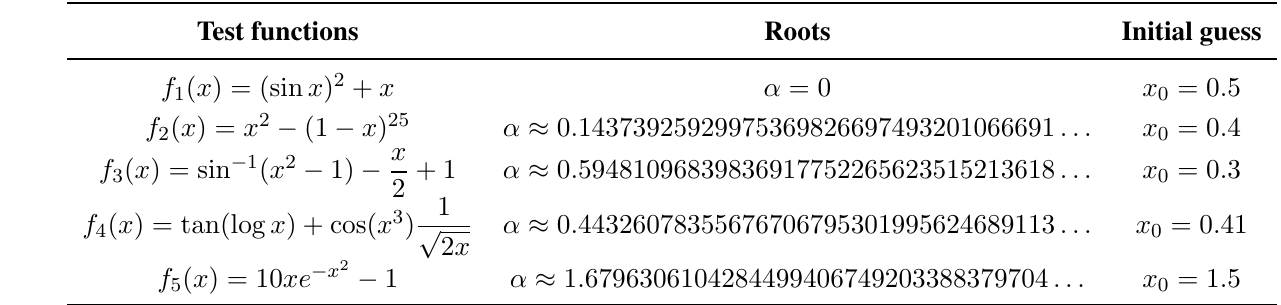
Table 1. Test functions and their